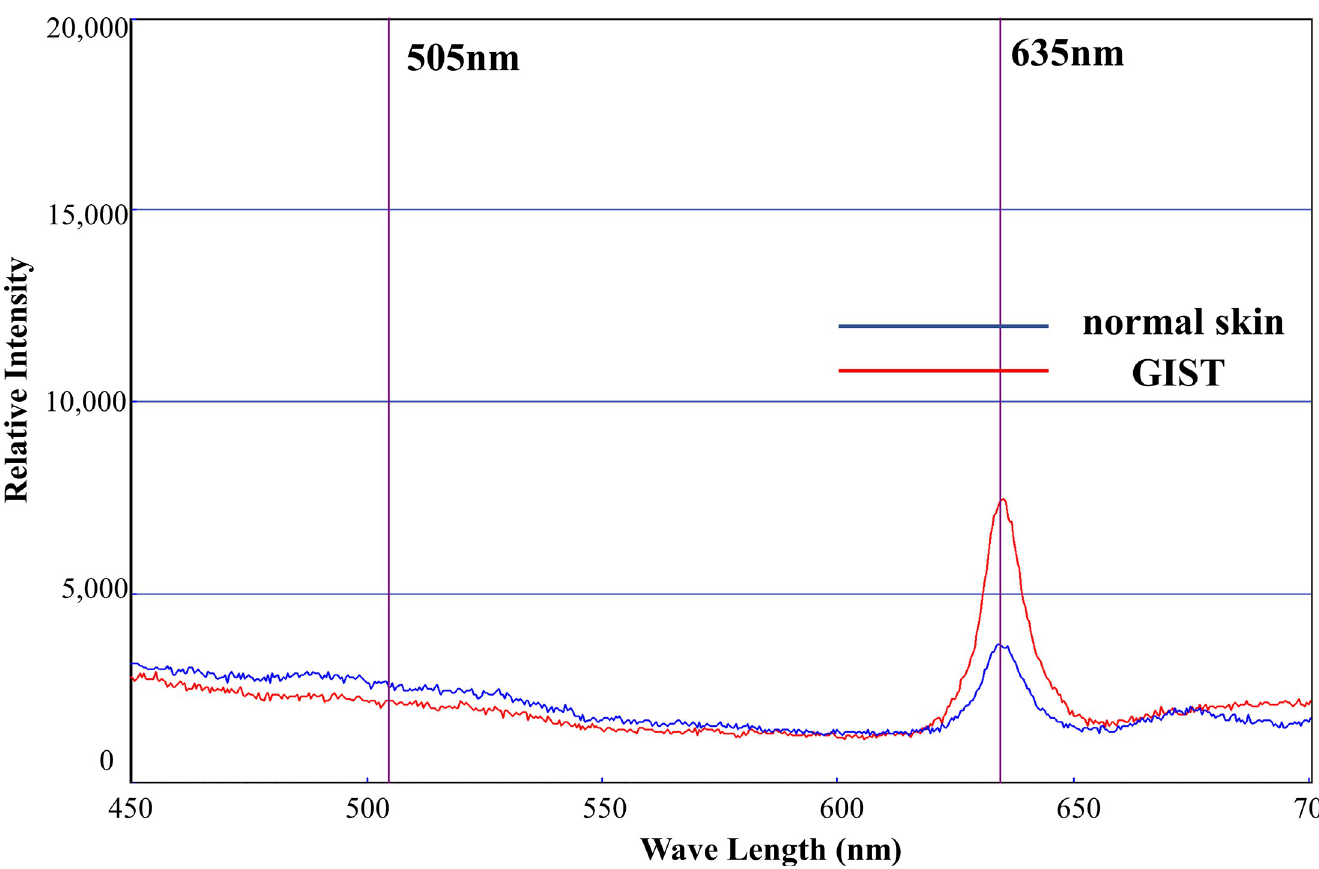
Fig 5. 5-ALA accumulation in GIST in vivo . Flank tumor models were administered with 300 mg/kg 5-ALA via the tail vein. Four hours after 5-ALA administration, the spectral waveforms of normal skin tissue (blue line) and GIST (red line) were examined using a VLD-M1 spectrometer. A peak of fluorescence emission was observed at 635 nm, corresponding to PpIX.